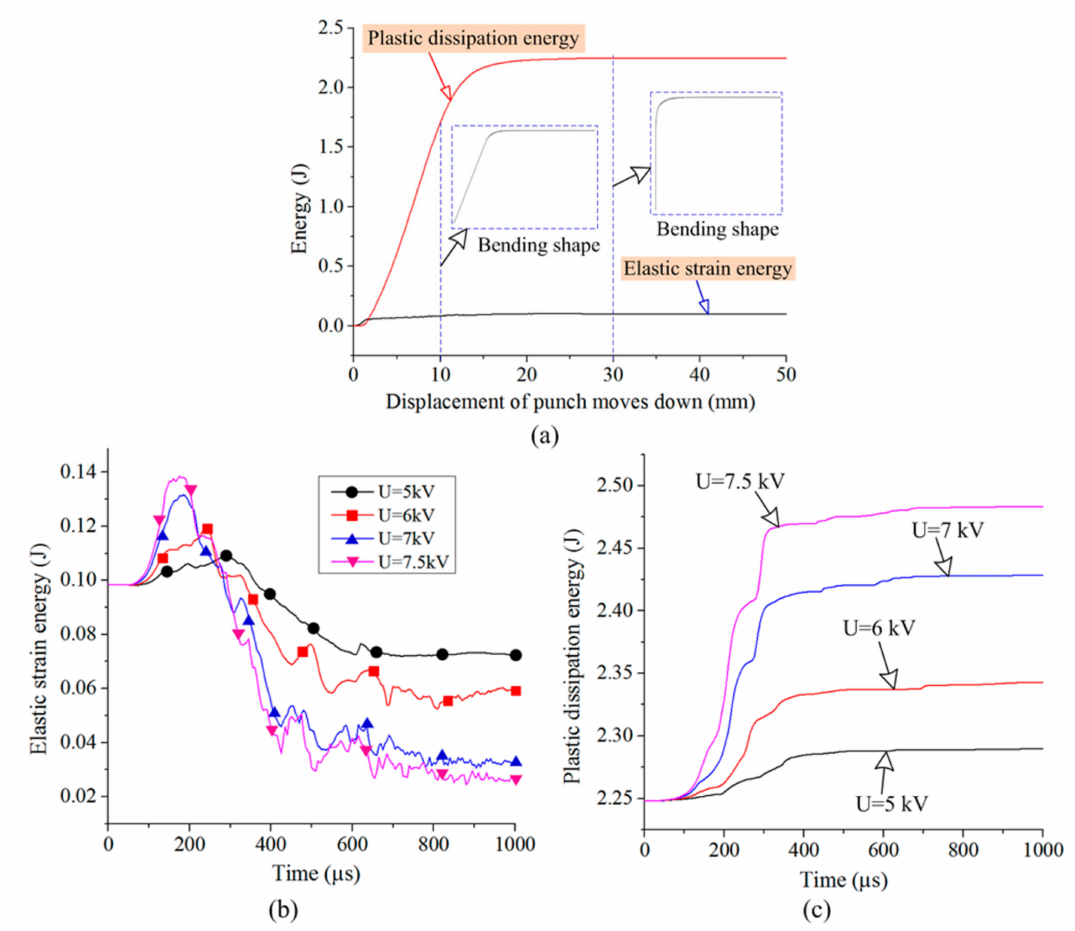
Figure 17. Changes of energy during stamping and electromagnetic forming (EMF) ( a ) quasi-static stamping, ( b ) elastic strain energy by EMF, and ( c ) plastic dissipation energy by EMF. The tangential tensile stress, compressive stress, and elastic strain energy all decrease significantly after coil discharge, as shown in Figures 14–17, due to the springback of the metal sheet being related to the bending moment produced by the tangential stress in the bending region. Therefore, a smaller tangential stress in the bending region results in a smaller bending moment and a smaller springback angle. Moreover, the smaller the elastic strain energy, the smaller the springback. Figure 18 shows the springback angle with various discharge